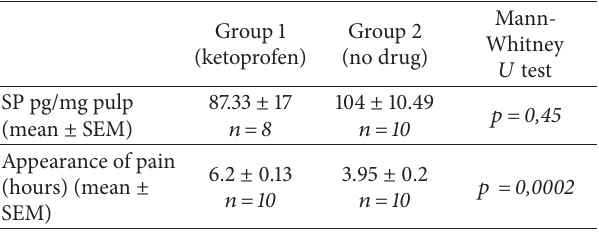
Table 3: Pulp substance P levels and time to appearance of pain. Group